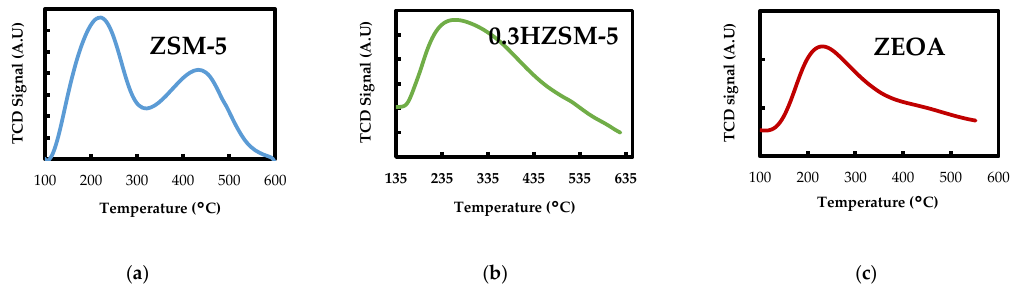
Figure 3. Characteristics (SEM, BET and TPD) of ( a ) ZSM-5, ( b ) 0.3HZSM-5 and ( c ) ZEOA.